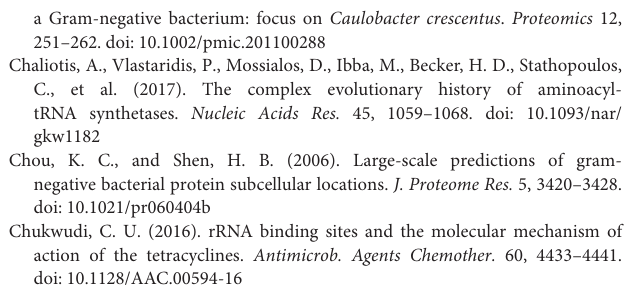
Figure S3 | Comparisons from sequencing results of the genetic deletion mutants by BLAST online software. The possible mutants were sequenced with P7 and P8 primers and compared to their genes in A. hydrophila used on online software BLAST. Figure S4 | Growth curves of the mutants and A.h - OXY-O under serial concentrations of OXY stress. The growth curves of wile-type strain and mutants were measured for 12h in different concentrations of 0, 5, 10, 20, and 40 µ g/mL OXY. Figure S5 | Survival capabilities of A.h - OXY-O and 1 AHA_1181 treated with a series of OXY concentrations (0, 5, 10, 20, and 40 µ g/mL) for 12h and observed by colony counting. (A) the CFU of them under each concentration of OXY treatment (log10 scale on the y-axis). (B) the survival ratio of wild type and 1 AHA_1181 mutant when treated with serial dilutions of OXY concentrations for 12h. Figure S6 | Western blotting analysis for differential outer membrane proteins contained the prestained protein ladder. The prestrained protein marker was used to detect the molecular weights of proteins, and the expected size of BamA. YidC, A0KLQ6, and A0KJB5 was 90 kDa, 60 kDa, 49 kDa, and 18 kDa, respectively. Figure S7 | The validation of the specificity of antibodies by Western blotting. Western blotting was used to detect the specificity of these polyclonal antibodies in A.h -OXY-O. Coomassie staining was used as the loading control (on the right). The expected size of A0KLQ6, A0KJB5, YidC, and BamA was 49 kDa, 18 kDa, 60 kDa, and 90 kDa, respectively. Figure S8 | The specificity of anti-YidC and BamA was further validated in knock-out strains by western blotting. The specificity of two antibodies were examined in 1 AHA_4281 (yidC) and 1 AHA_1181 (bamA) , and coomassie staining was used as the loading control. File S1 | The base sequences of knockout mutants analyzed by the primer pairs P7 and P8. Each mutant was sequenced with P7 and P8 primer, and their base sequences were presented in